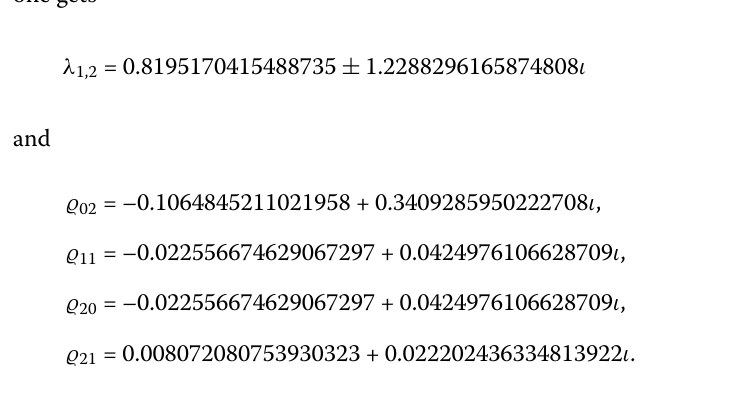
one gets λ 1,2 = 0.8195170415488735